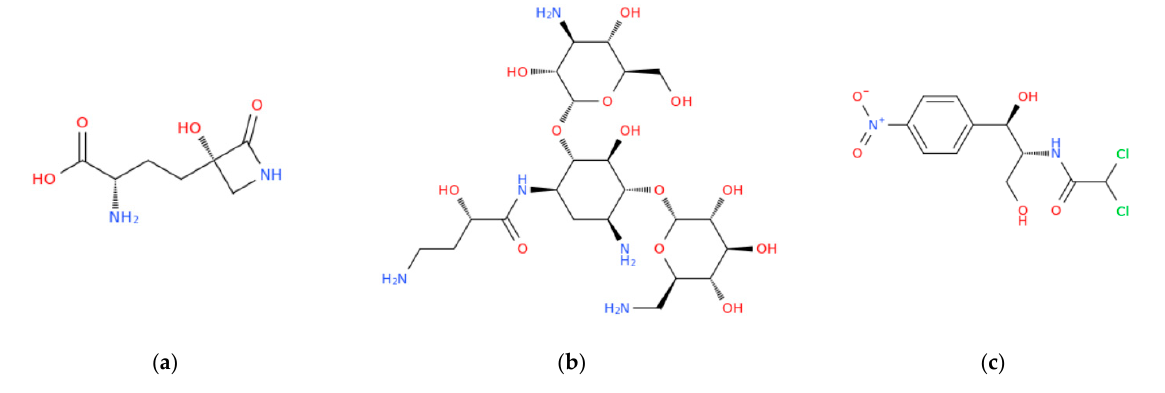
Figure 1. Structural representation of three examples of antibiotics taken from the three